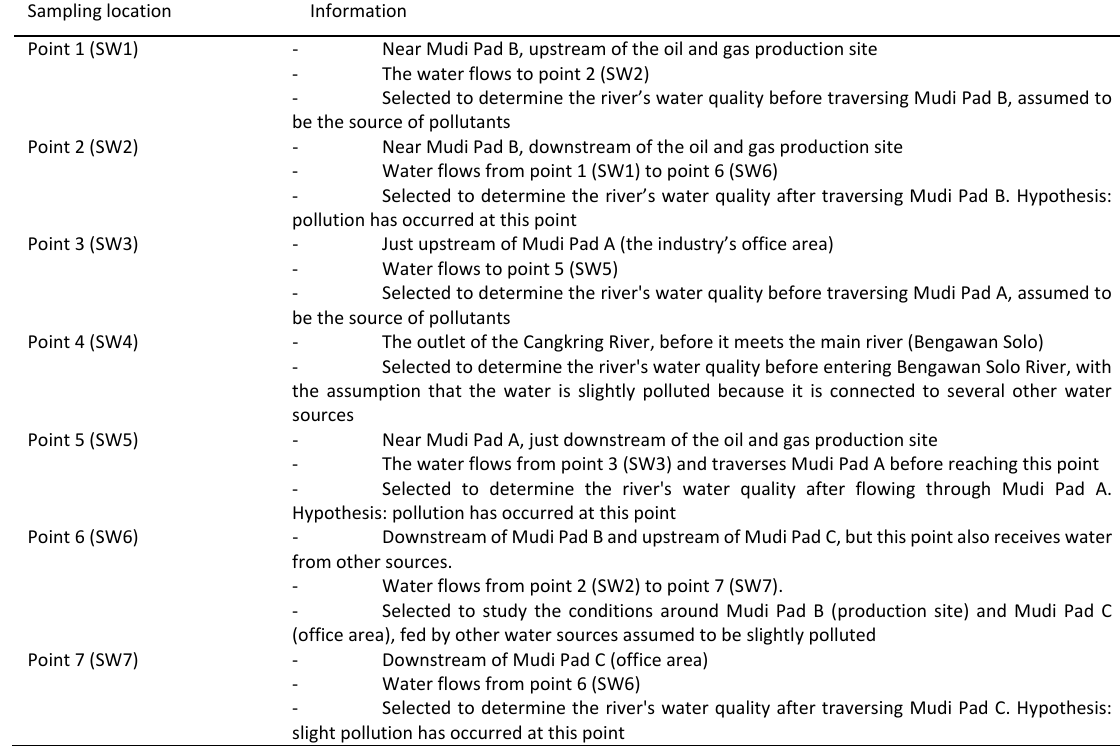
Table 1: Water sampling locations and tested hypotheses